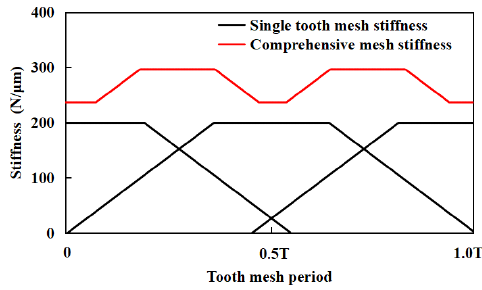
Figure 4. Meshing stiffness contains multiple pairs of teeth meshing.